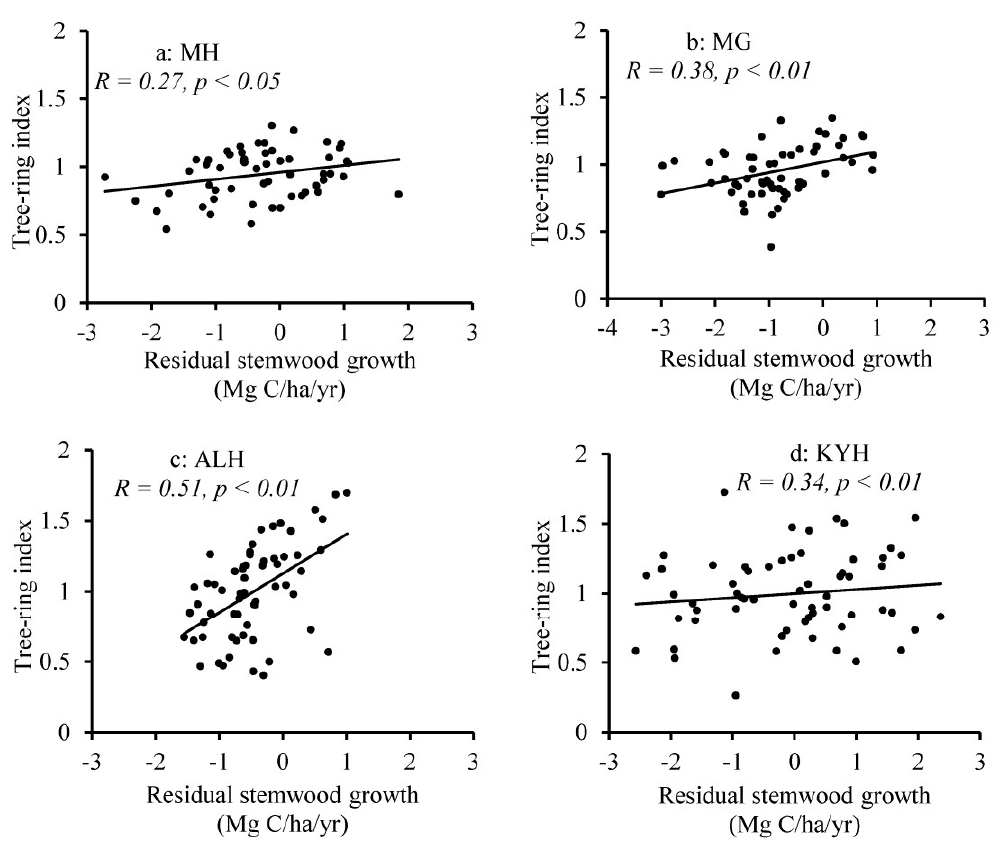
Figure 8. Comparison of the standard (STD) chronologies (black line) and the residual stemwood